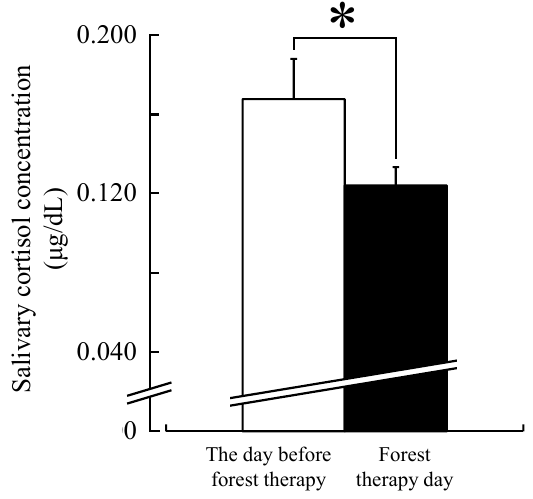
Figure 3. Effect of forest therapy on salivary cortisol level. N = 17, mean ± standard error. * p < 0.05, paired t -test.